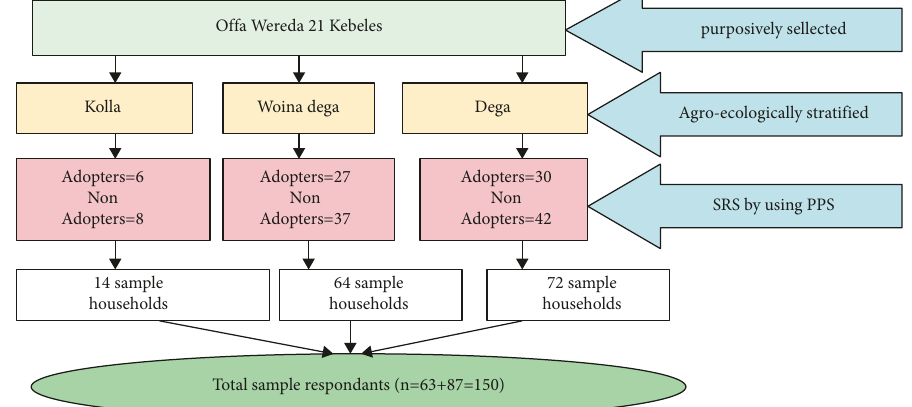
Figure 3: Sampling procedure.